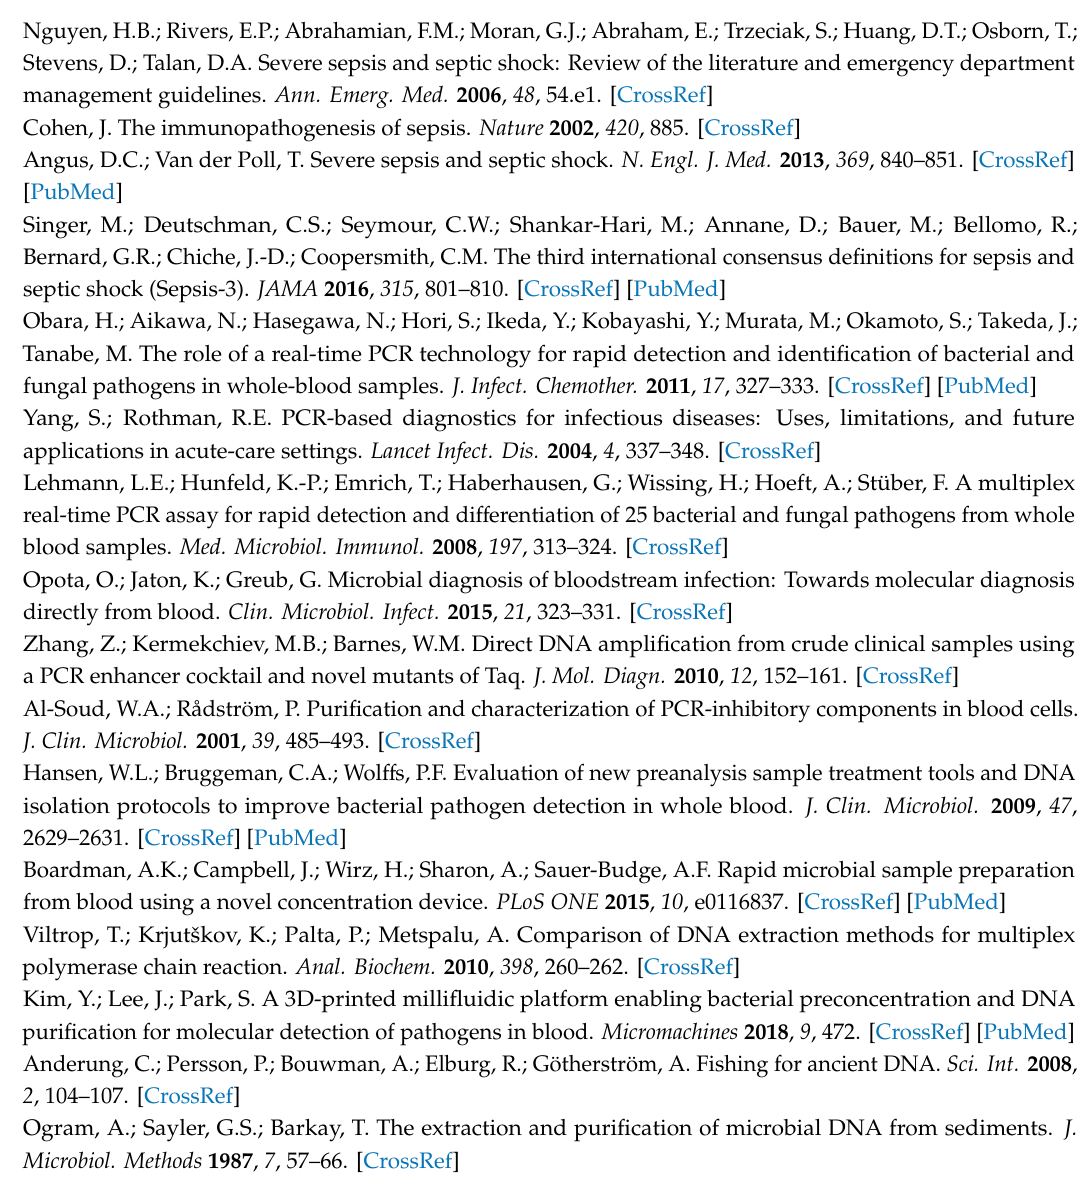
Figure S1: The helical microchannels for magnetic preconcentration of bacteria of interest. Figure S2: Amplification of a target gene ( eae ) in E. coli O157:H7 in blood by PCR and quantitative PCR (qPCR) without any DNA purification process. Figure S3: Amplification of the target gene (eae) in E. coli O157:H7 in blood with the use of commercial DNA purification kits (MagListoTM 5M Genomic DNA extraction kit, MagJET Genomic DNA kit, and